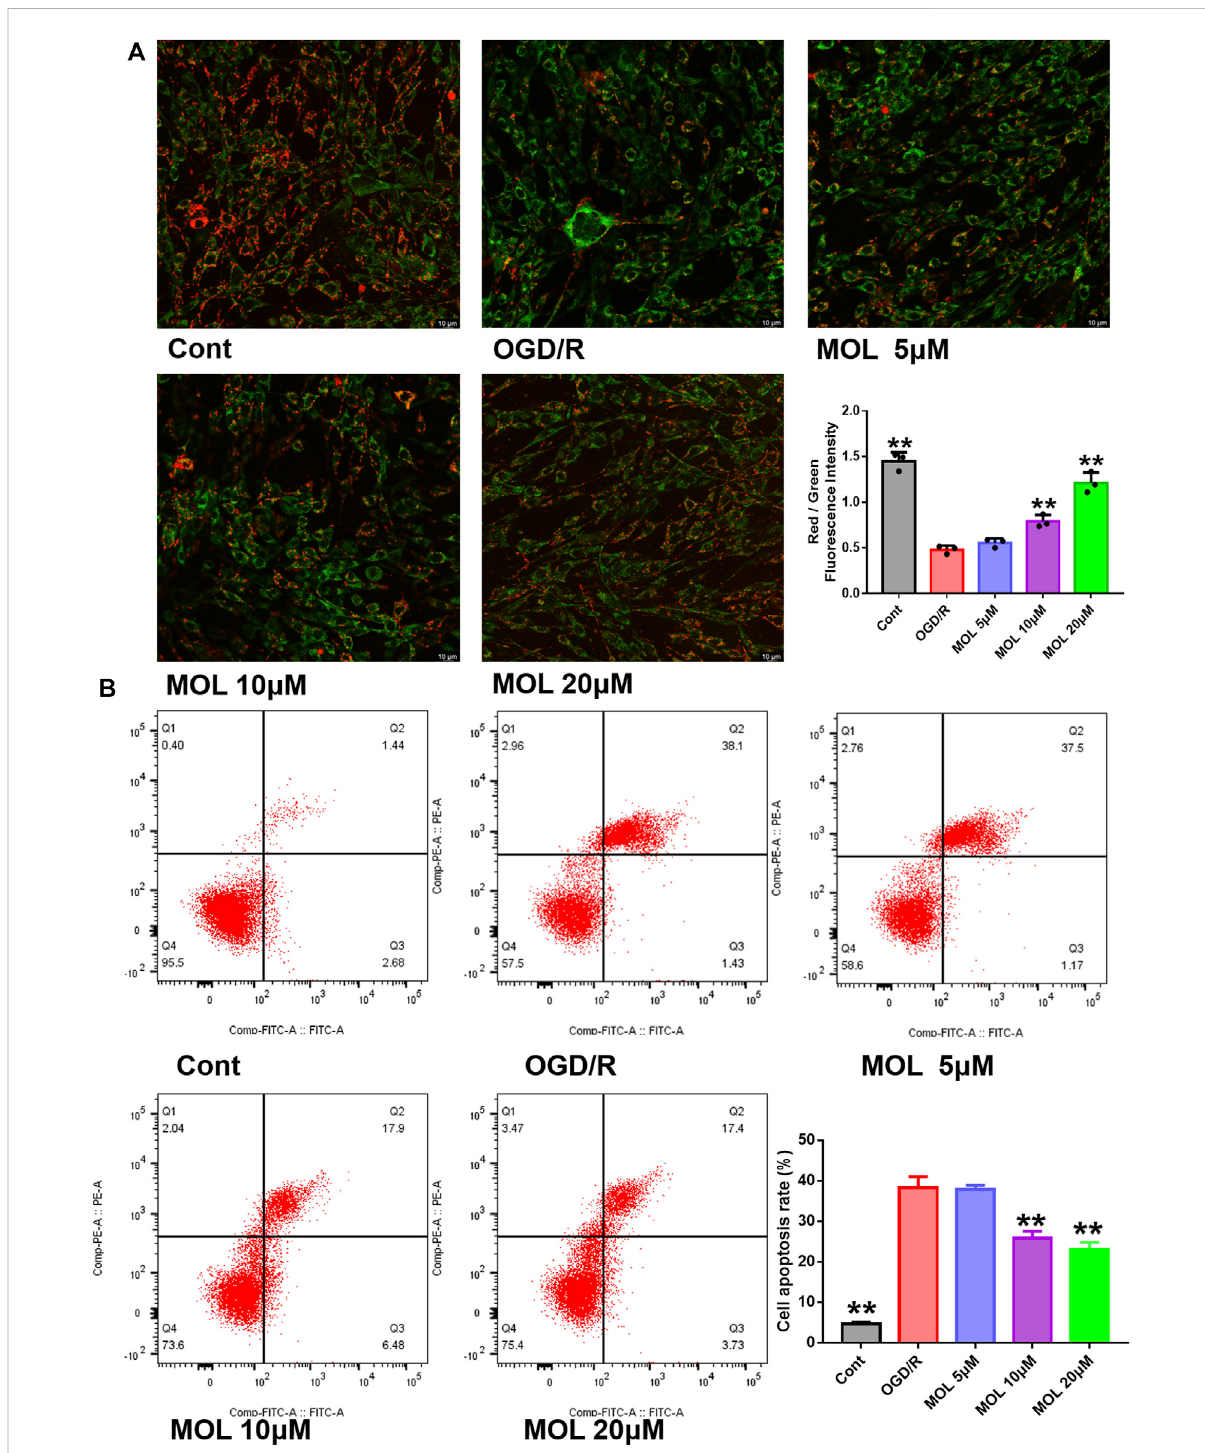
FIGURE 5 MOL inhibited the MMOP collapse and apoptosis of SHSY-5Y cells induced by OGD/R treatment. (A) JC-1 staining was used to observe the changes of MMOP in SHSY-5Y cells treated with MOL (5, 10, 20 μ M) and OGD/R. (B) Flow cytometry was used to detect the apoptosis of SHSY-5Y cells after MOL (5, 10, 20 μ M) and OGD/R treatment. Data expressed as Mean ± SD, ** p < 0.01, * p < 0.05 vs. OGD/R